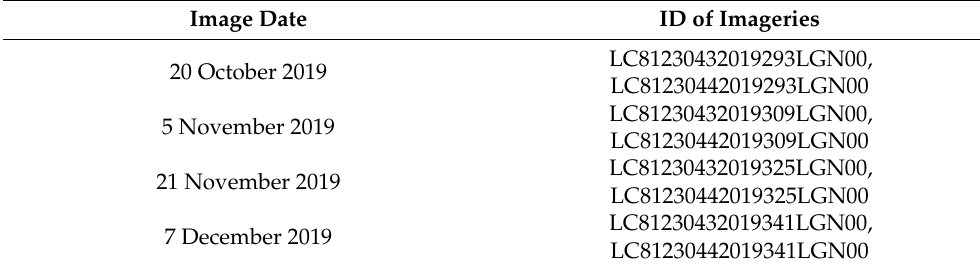
Table 2. Landsat 8 OLI series of